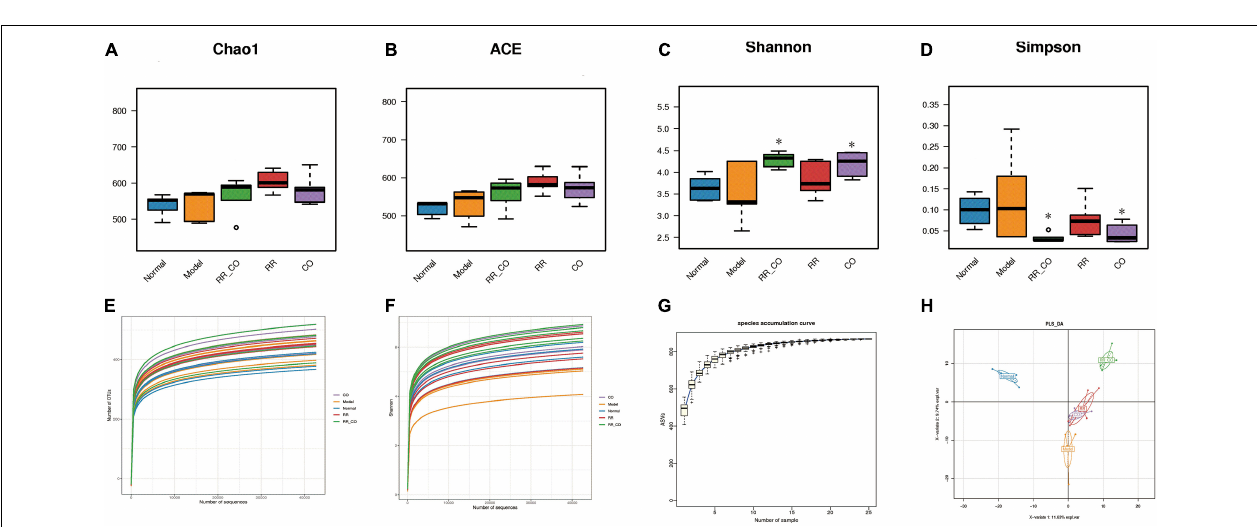
FIGURE 2 | The effects of RR-CO on inflammation in the testes and colon of DM mice. (A–C) The expression of IL-6 and TNF- α in testicular tissue of DM mice. (D–F) The expression of IL-6 and TNF- α in the colon of mice. Data are expressed as mean ± SD. # P < 0.05; ## P < 0.01 vs. normal group. * P < 0.05; ** P < 0.01 vs. model group; n = 3.